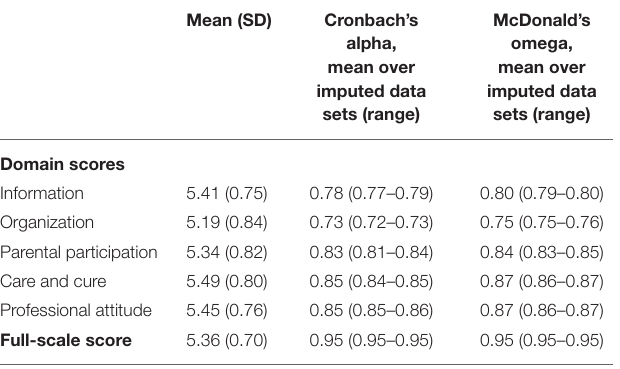
TABLE 3 | Internal consistency reliability of the EMPATHIC-30 domain scores and full-scale score ( n = 178).